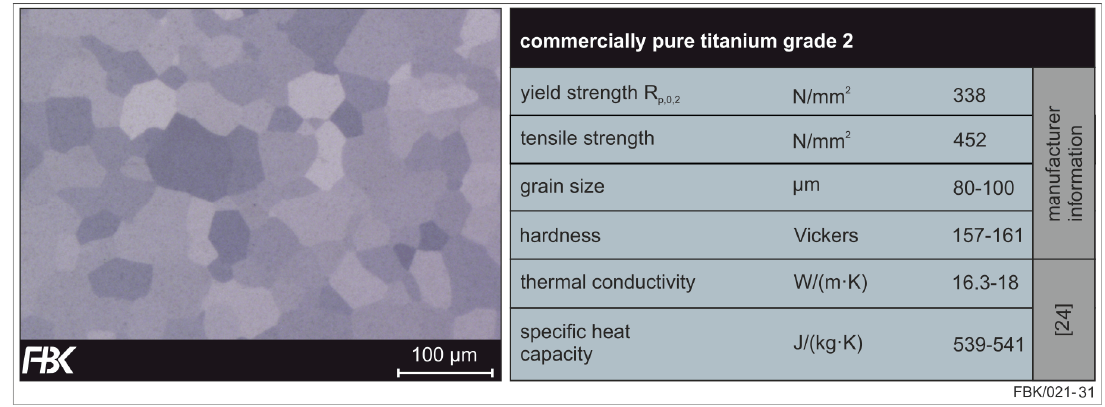
Figure 12. Etched cross-section ( left ) and properties of commercially pure (CP) titanium grade 2 ( right ) after [35].